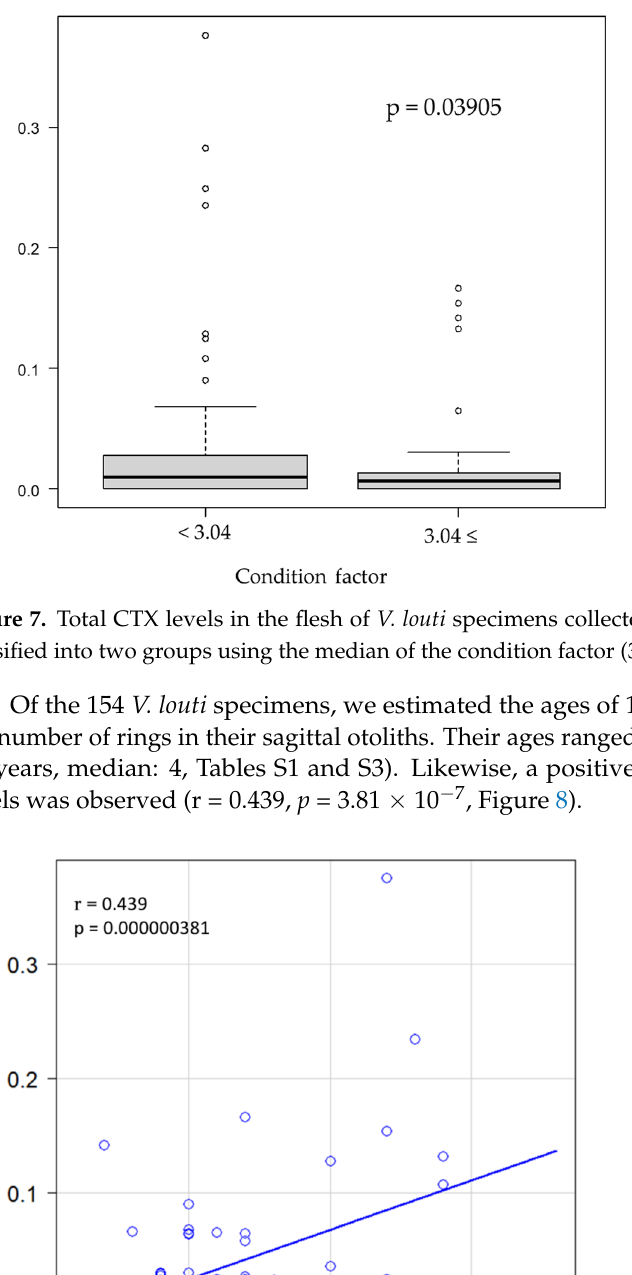
Figure 6. The relationship between fish size (( a ): SL, ( b ): BW) and total CTX levels in the flesh of V. louti specimens collected from Ryukyu Island, Japan.